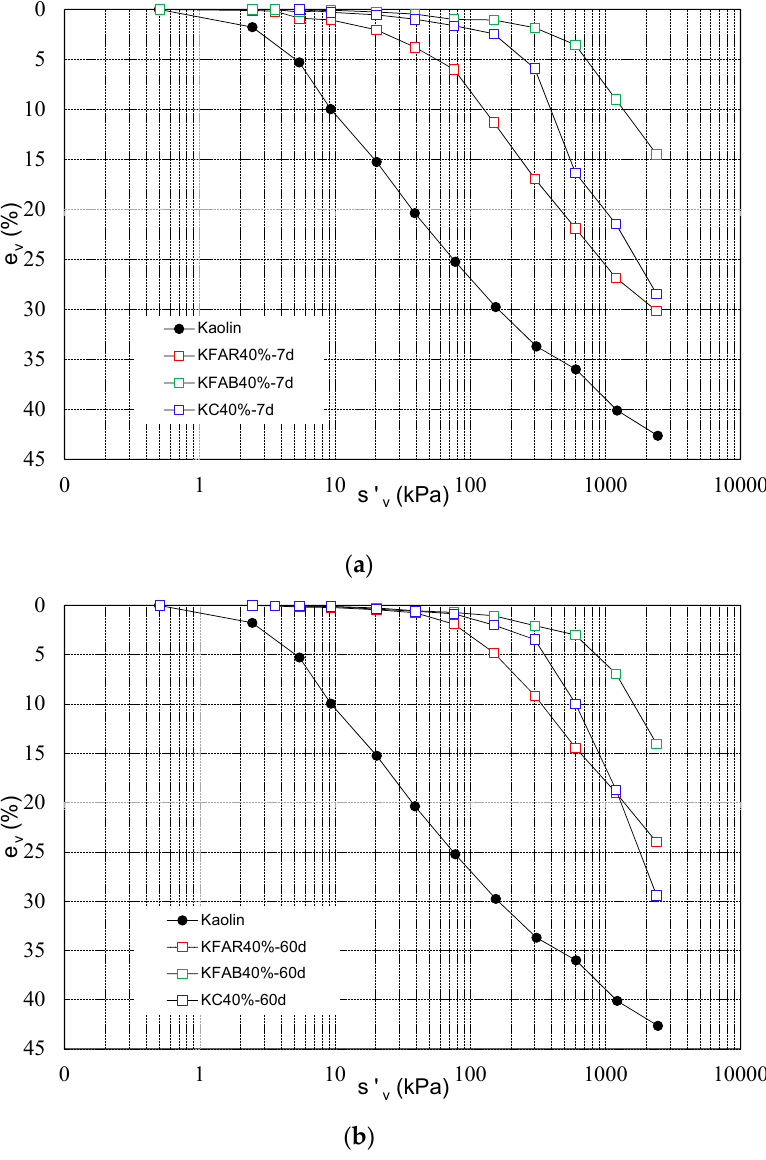
Figure 5. One dimensional compression tests on not treated and treated kaolin as function of type of binder: ( a ) 7 days of curing; ( b ) 60 days of curing.